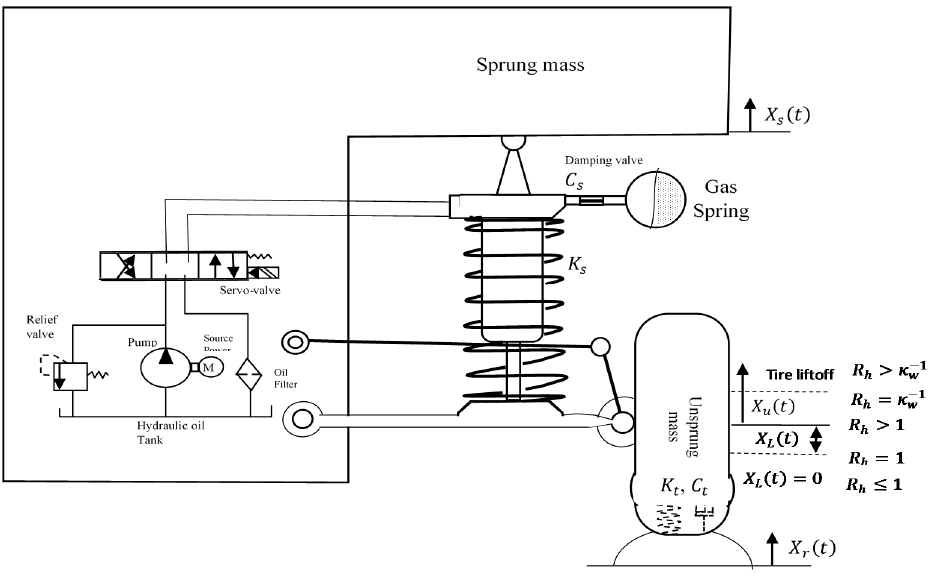
Figure 2. Dynamic landing tire system.